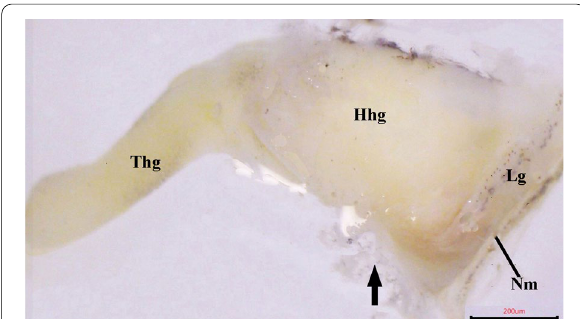
Fig. 1 A photomacrograph of the Harderian gland (Hg) and lacrimal gland (Lg) of Egyptian agama, Trapelus mutabilis, showing the shape of the Harderian gland with head (Hhg) implanted in the connective tissue capsule (arrow), granular tail (Thg), small lacrimal gland appearing nearly white in color, and the nictitating membrane (Nm)